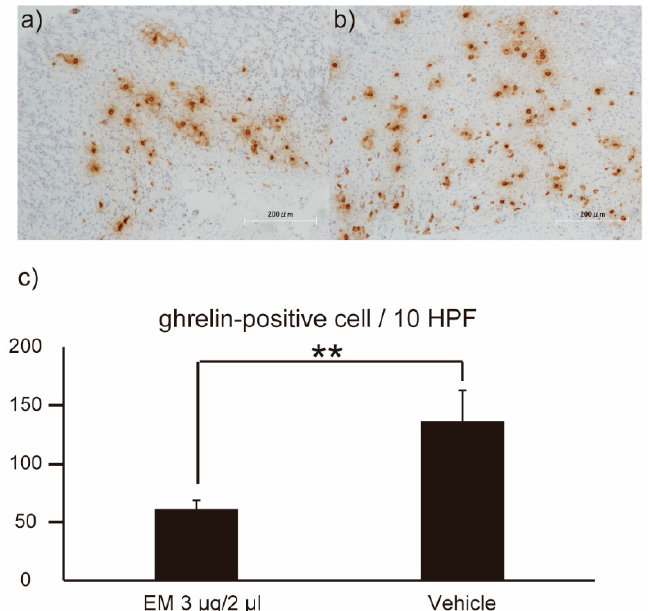
Figure 8. Immunohistochemical staining for ghrelin expression in the stomachs of mice. Representative micrographs are provided showing the distribution of ghrelin-positive cells (brown staining) in the stomachs of mice administered EM ( a ) or vehicle ( b ). The numbers of ghrelin-positive cells/10 high power field (HPF) were quantified in stomachs from n = 5 mice ( c ). Values represent the mean ± SD for the indicated number of animals. ** p < 0.01 (Unpaired Student’s t -test).